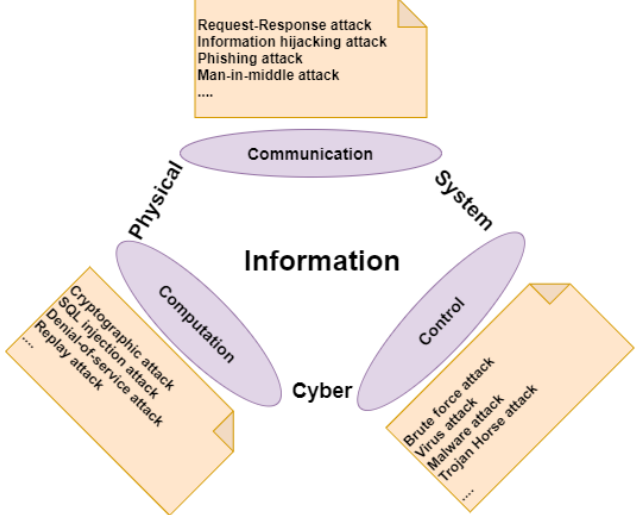
Figure 1. Cyber Threats in Social